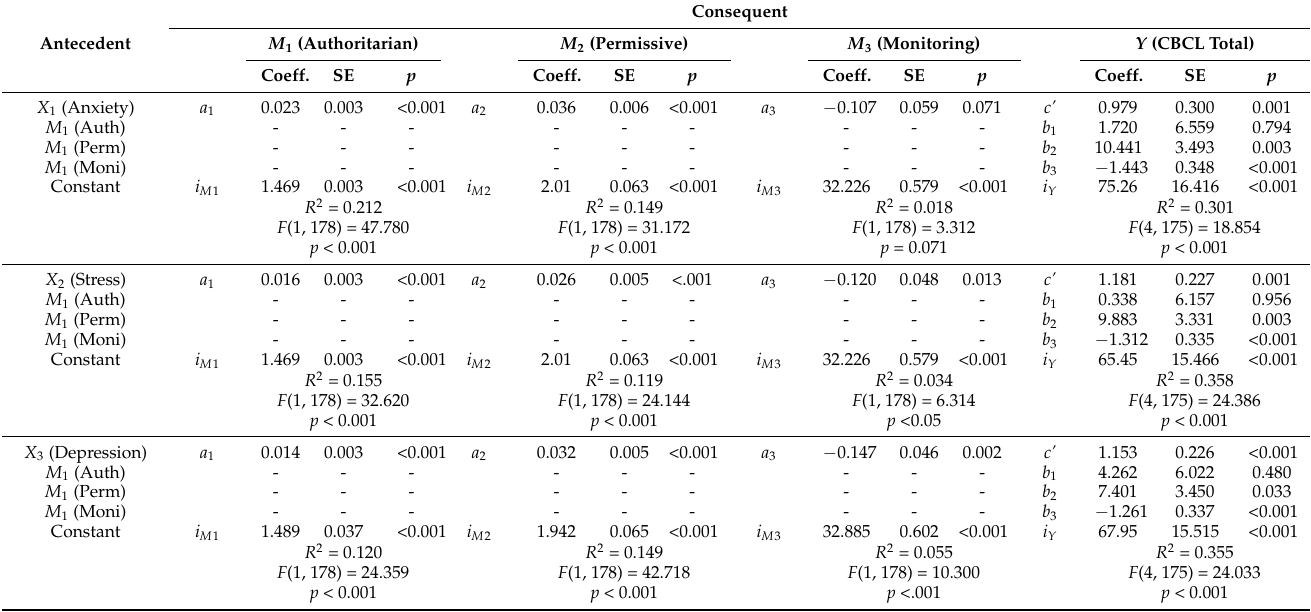
Table 3. Regression coefficients, standard errors, and model summary information for the parallel multiple mediator model ( n =